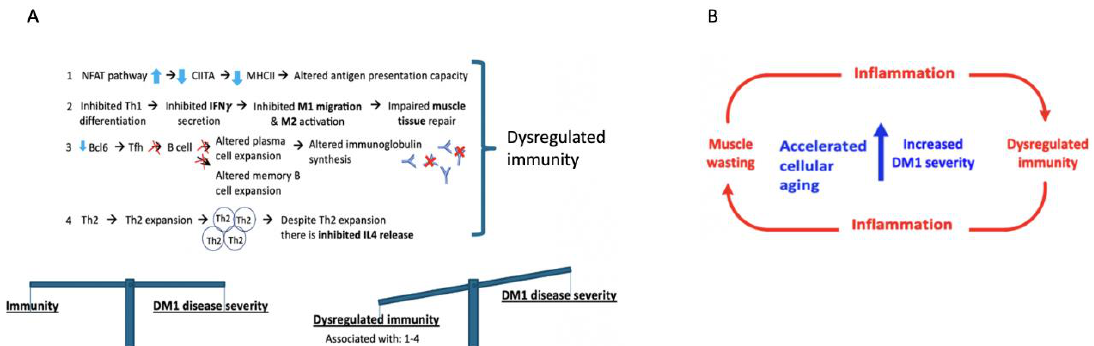
Figure 8. ( A ) A hypothetical framework (based on pilot data presented here) highlights four key immune processes which are possibly dysregulated. 1; higher expression of the NFAT pathway results in impaired antigen presentation capacity, through lowered CIITA and MHCII gene expression. 2; impaired Th1 differentiation which may lead to diminished IFNγ release, which normally controls macrophage subtype 1 (M1) migration and M2 activation which guide muscle tissue repair [37]. 3; diminished follicular helper T (Tfh) cell differentiation resulting in altered B memory cell expansion and altered plasma B cell expansion which may result in less antibody synthesis [38]. 4; Th2 expansion coupled with lowered IL4 expression with increased DM1 severity. Together these affected pathways may result in dysregulated immunity resulting in a more severe DM1 phenotype. ( B ) Schematic representation of the concept that increased DM1 severity is associated with accelerated cellular aging, muscle-wasting, and dysregulation of